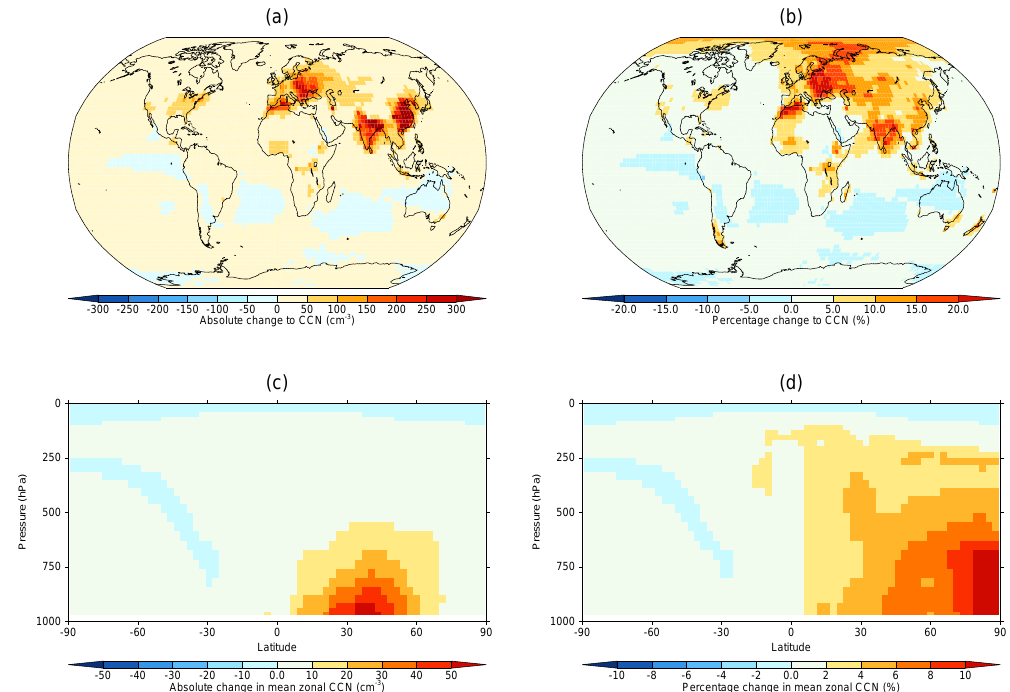
Figure 12. Simulated absolute and percentage change in annual mean surface (a–b) and zonal (c–d) soluble N 50 concentrations due to residential emissions (res_base), relative to an equivalent simulation where residential emissions have been removed (res_base_off).